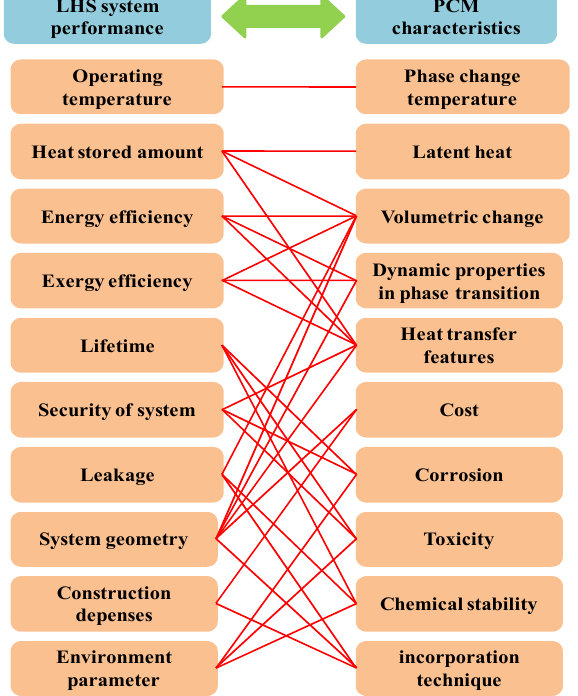
Figure 13. Influence of PCMs on performance of LHS system, reprinted/adapted with permission from Ref. [3], 2022, Springer Nature.